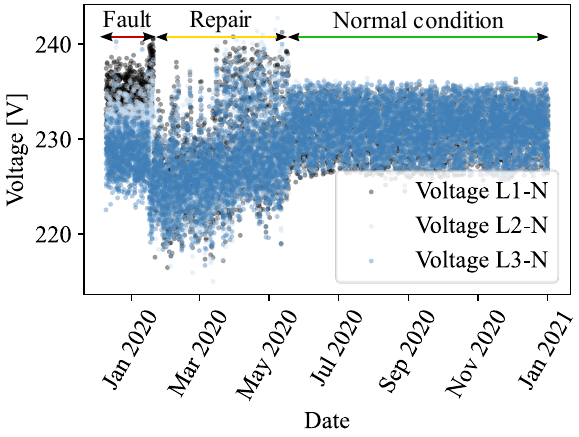
Figure 10. Voltage of the transformer for the period under review. The difference in the vibration amplitude of the normal-condition measurements (meas. NC) and the abnormal-condition measurements (meas. AC) can be seen in the box plots in Figure 11. The abnormal condition results in higher vibration amplitudes. The distribution of the abnormal-condition measurements has a median of 0.024 m/s 2 and reaches amplitudes up to 0.046 m/s 2 , whereas the distribution of the normal-condition measurements has a median of 0.014 m/s 2 , and the maximum occurring value is 0.019 m/s 2